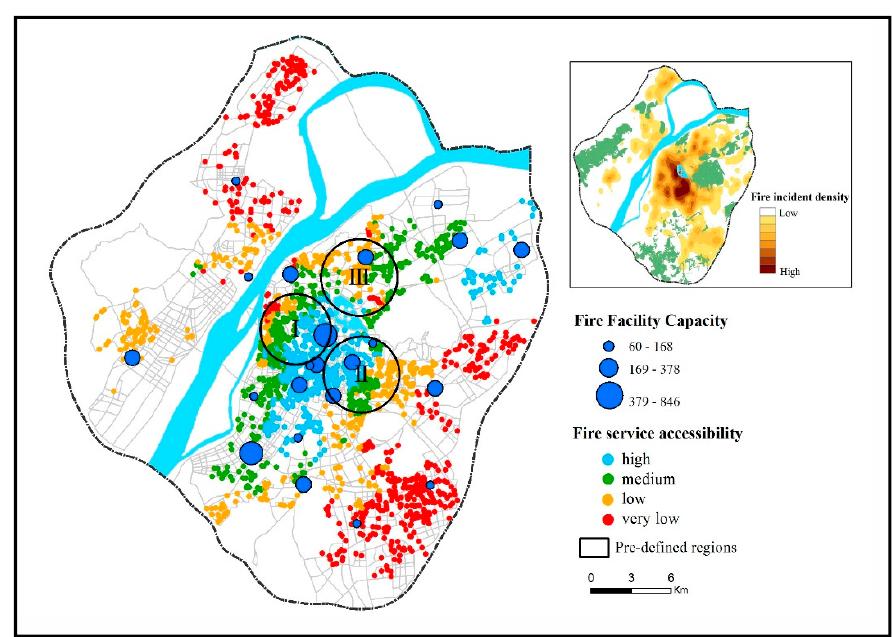
ISPRS Int. J. Geo-Inf. 2019 , 8 , x FOR PEER REVIEW Figure 4. Spatial distribution of accessibility scores using the original 2SFCA method.